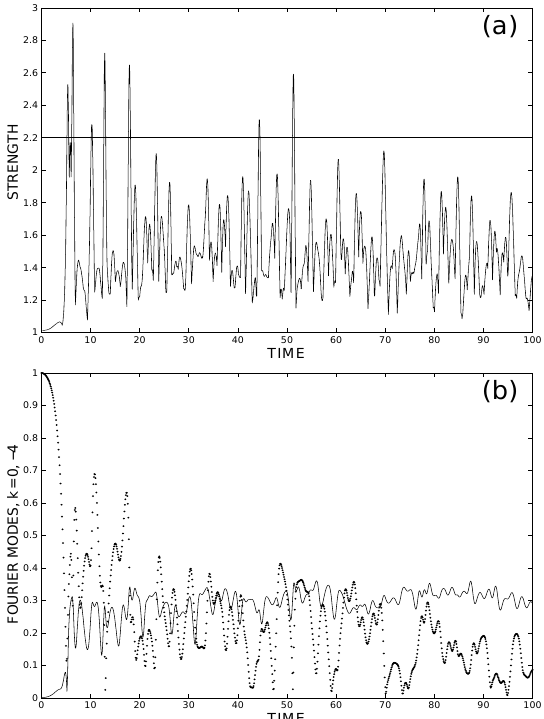
Fig. 11: The evolution of k peak for the nonlinearly damped HONLS equation with ǫ = 0 . 05 , Γ = 0 and (a) β = 0 . 04 or (b) β = . 5 for initial data (17).